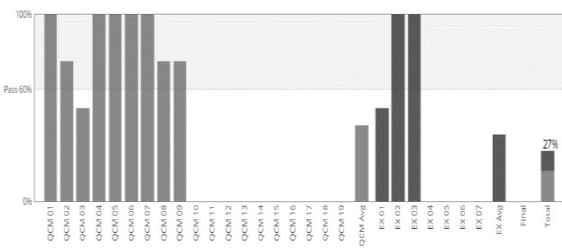
Figure 3: Progress of a student towards the end of week 3 of session 1, Spring 2019.